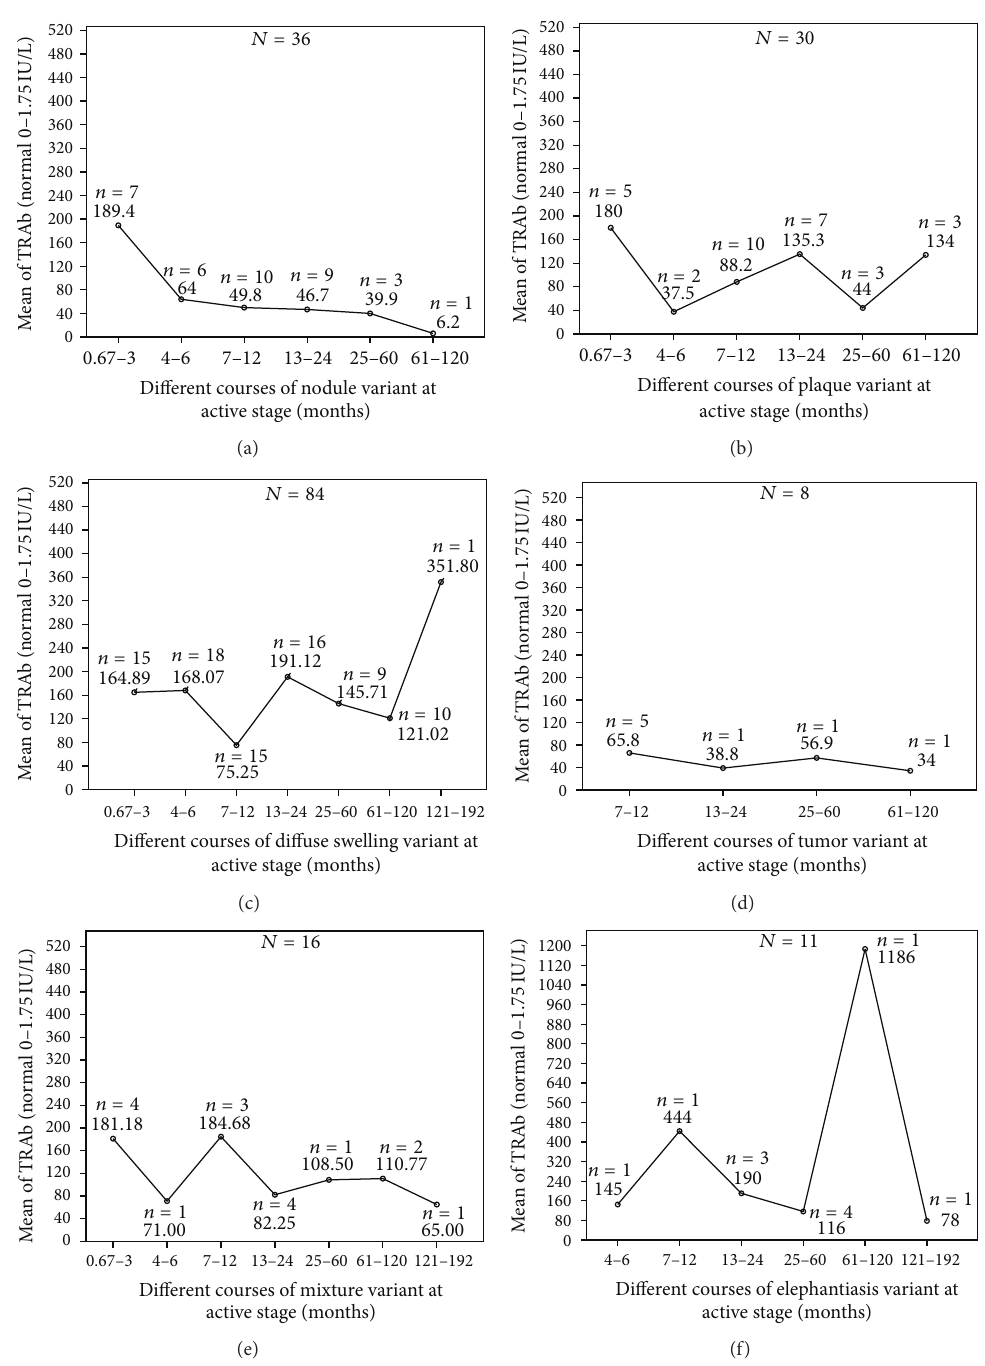
Different courses of elephantiasis variant at active stage (months)